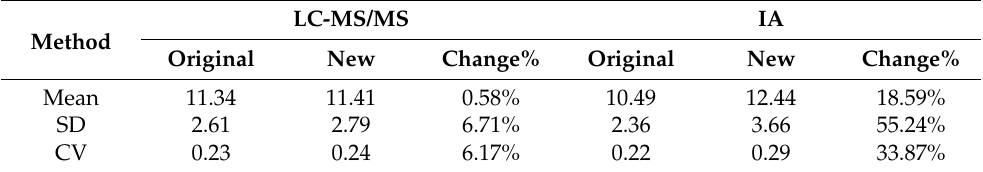
Table 8. Mean, SD and CV of FT4 transformations into the ED scale by piecewise linear